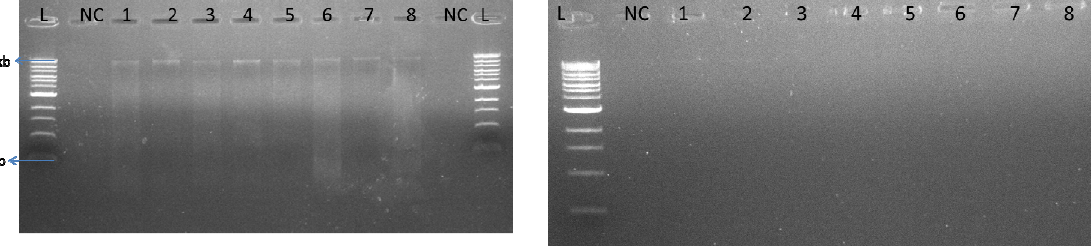
Fig. 1. Plasmid profile of Pseudomonas sp. and Staphylococcus sp. isolated from soil samples, analyzed with 0.8% agarose gel electrophoresis stained with ethidium bromide Key: L is 0.5kb - 48.5kb ladder (molecular marker). Samples 1, 2, 3, 4, 5, 6, 7 and 8 are positive for plasmid genes with band at 30 kb . NC is a no plasmid DNA template control.